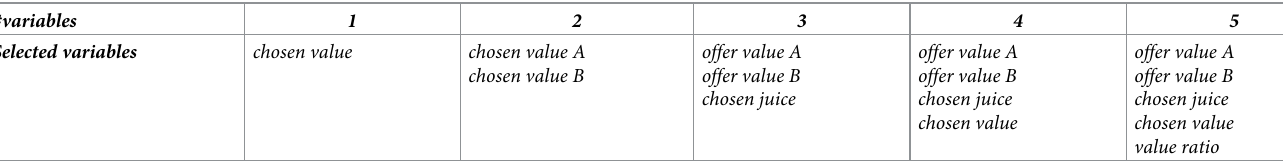
Table 2. Selected